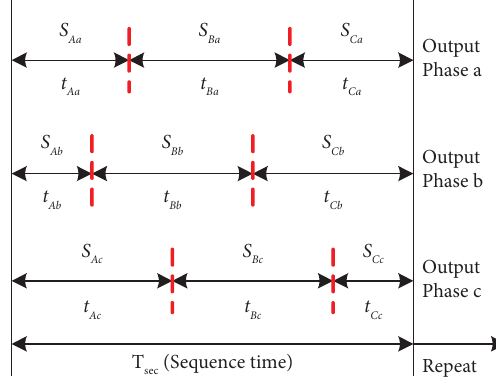
Figure 3: CMC switching